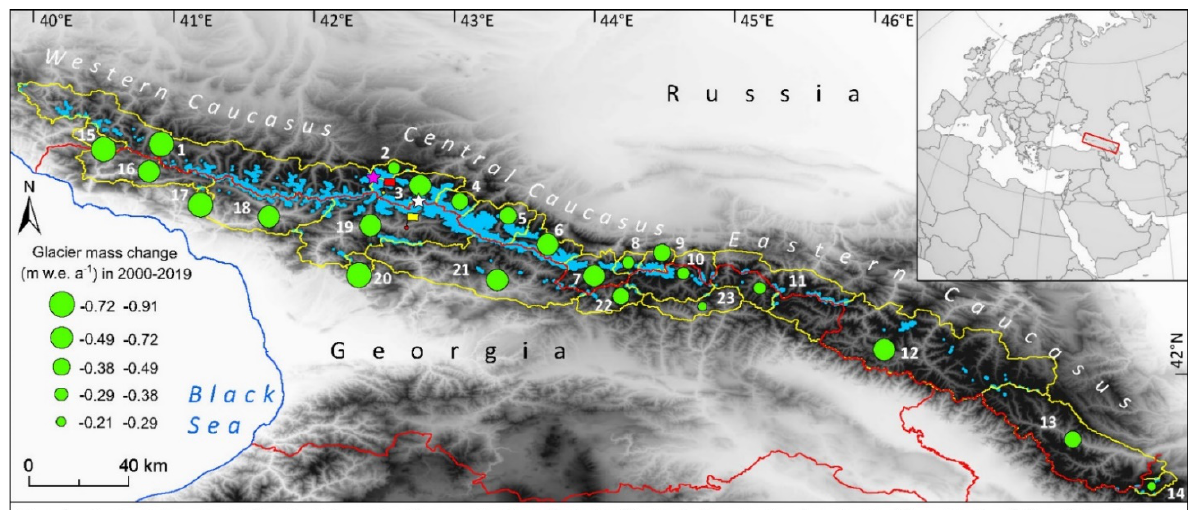
Figure 1. Glacier extent in 2014 in the Greater Caucasus according to the main river basins. Green circles correspond to changes in glacier surface mass balance (m w.e. a −1 ) according to individual river basins. See also Table A1 to compare mass balance data relative to all river basins. About 13.4% of the surface area of Caucasus glaciers was covered by debris in 2014 [38]. Nowadays, there are more than 2200 glaciers in the Greater Caucasus, covering an area of about 1060 km 2 . The northern slopes of the mountain range contain more glaciers than the southern slopes. About 70% of the modern glaciated area is concentrated in the central section. Fourteen glaciers have an area > 10 km 2 resulting in ~220 km 2 or ~21% of the total glacier area in 2020. The Bezingi Glacier, with an area of ~39 km 2 , was the largest glacier mapped in the 2020 database [37]. 3. Data and Methods In this study, we used geodetic mass balance and ice thickness data from Hugonnet et al. (2021), [3] obtained from 30 m resolution Terra Advanced Spaceborne Thermal Emission and Reflection Radiometer (ASTER) Global Digital Elevation Model (GDEM) and ASTER L1A stereo images (each covering 60 km × 60 km) between 1 January 2000 and 31 December 2019 (downloaded from https://lpdaac.usgs.gov/products/ast_l1av003/) (Last access 13/12/2021). The specifically developed statistical methods are consistently described in Hugonnet et al. (2021) [3]. Outlines from the Caucasus glacier inventory from 2014 [21] were regarded as glacier boundaries in Hugonnet et al. (2021) [3]. These outlines for most glaciers in this area are identified according to the Landsat 8 Opera- tional Land Imager (OLI) images and downloaded from the EarthExplorer website (http://earthexplorer.usgs.gov/) (Last access 13/12/2021). The 5-year uncertainties by Hugonet et al., 2021 [3], at the 95% confidence level, were lower than 0.5 m yr −1 for glaciers larger than 1 km 2 and conservative for smaller glaciers. They, thus, validated the reliability of improved uncertainty approaches for volume change estimation down to the scale of individual glaciers. A detailed descrip- tion of uncertainty calculation is given in Huggonet et al., 2021 [3]. To check the accuracy of geodetic mass balance data by Hugonnet et al. (2021) [3] relative to the existing ground-based observation from the same period, we selected the Djankuat Glacier (Fig- ure 2a) and extracted its glaciological mass balance data from the WGMS server [20]. For more comparison with other geodetic mass balance studies, we also selected the Kyu-